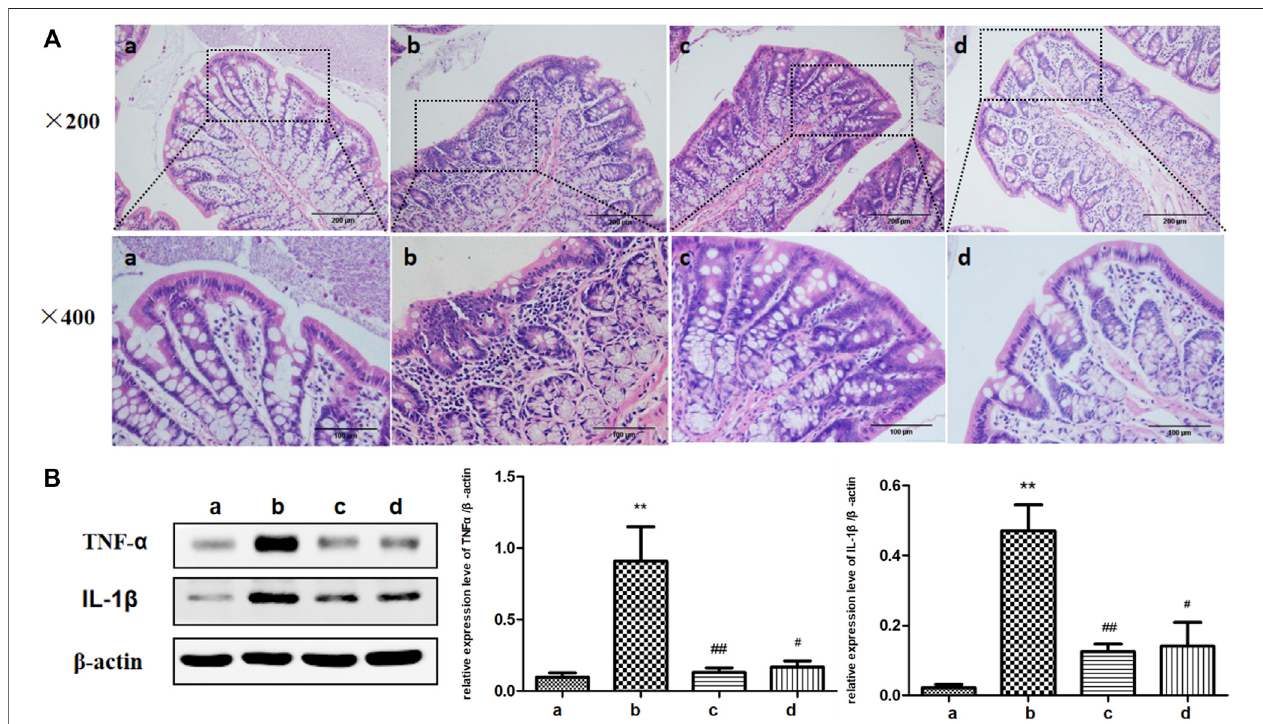
FIGURE 2 | Effects of ICA on colon in fl ammation in aging rats. (A) Representative fi gures ofHE of colonic epithelial morphology (×200, ×400). (B) The effect of ICA on the expressions of in fl ammatory cytokines TNF- α and IL-1 β in the colon of aging rats was detected by Western blot. a: Adult group, b: Aging group, c: Low dose of ICA-treated aging group (ICA-L group), d: High dose of ICA-treated aging group (ICA-H group). ** p < 0.01 vs. Adult group. # p < 0.05 vs. Aging group. ## p < 0.01 vs. Aging group, n = 4-8.